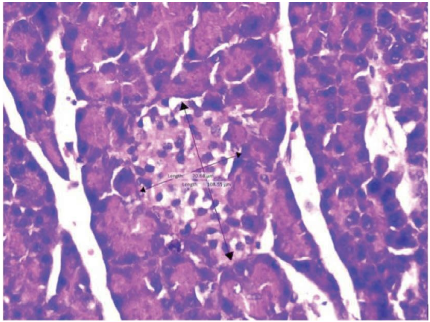
Figure 4: Method for measuring the diameter of the islets of Langerhans in the